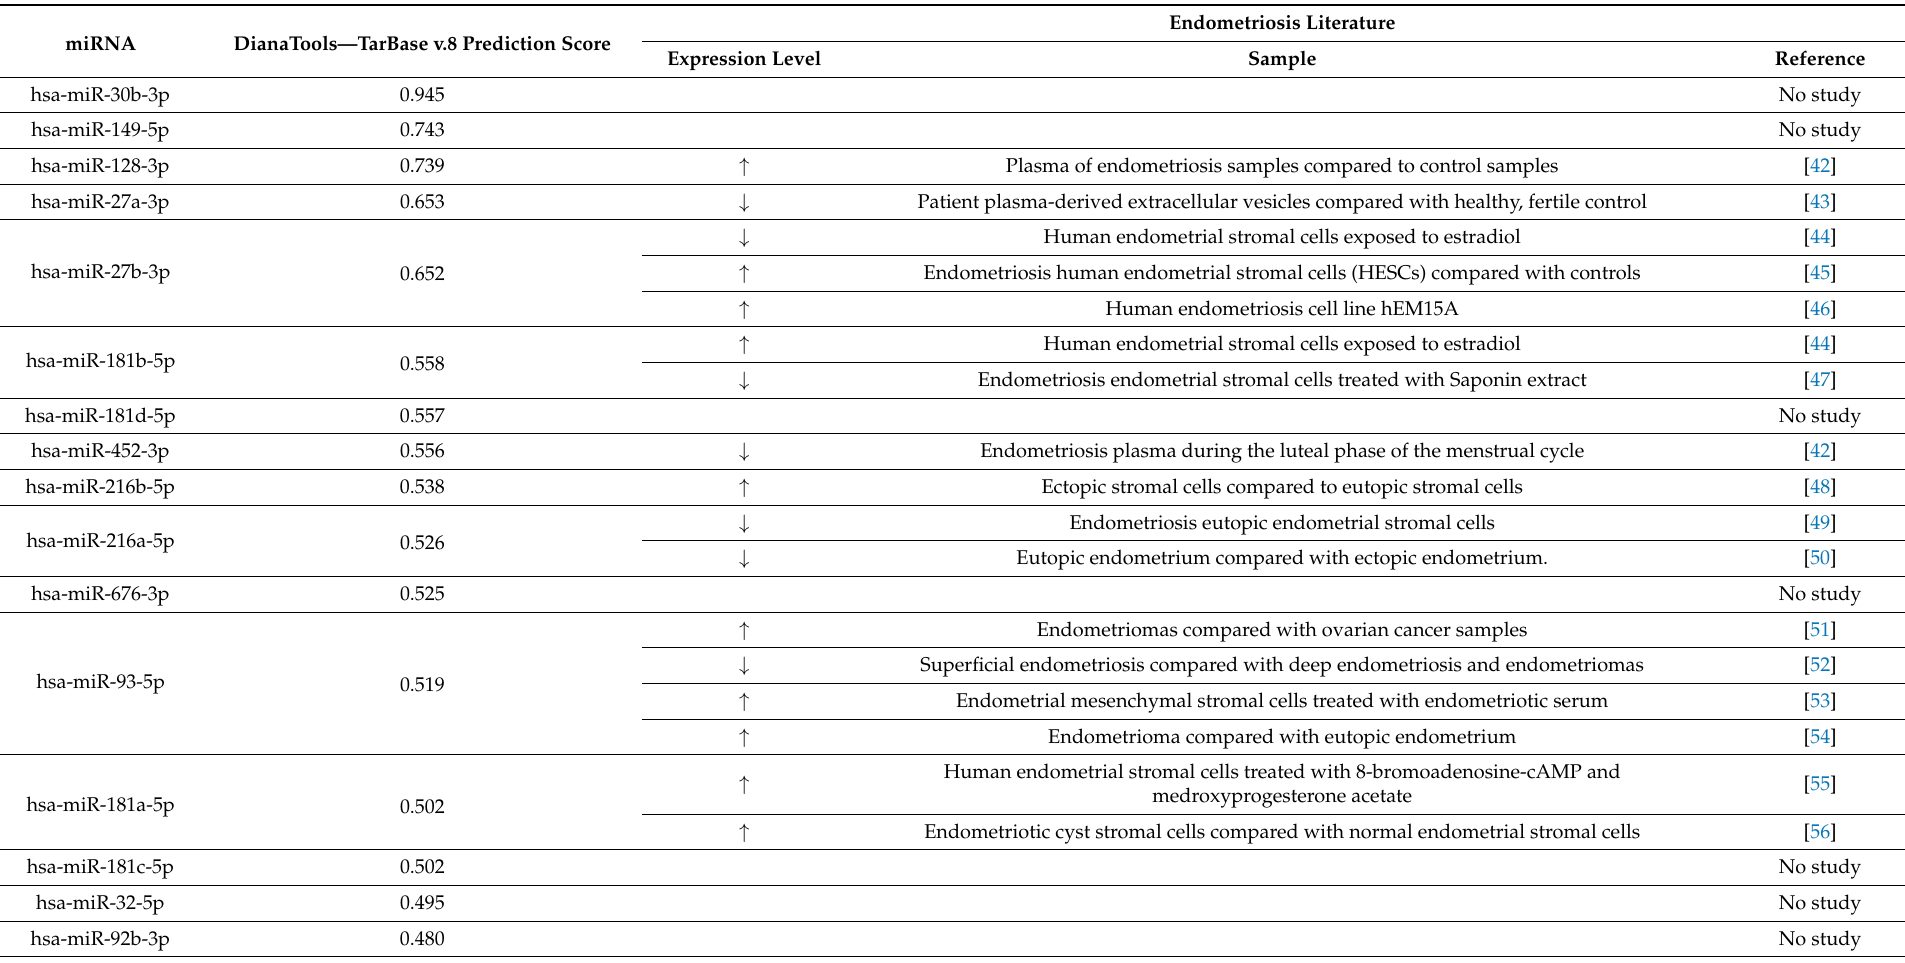
Table 1. MiRNAs that negatively regulate DROSHA were identified through an in silico analysis and reported in the literature as associated with endometriosis. miRNA DianaTools—TarBase v.8 Prediction